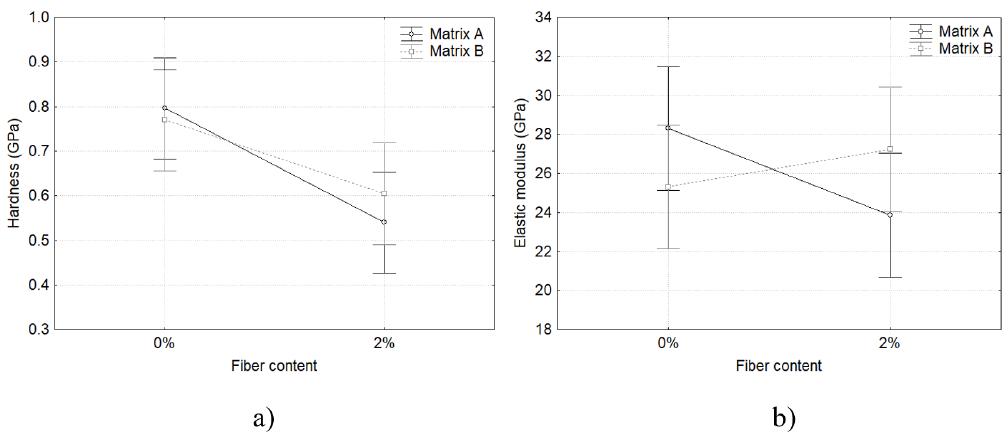
Figure 2. Results of hardness (a) and elastic modulus (b) obtained by the nanoindentation technique applied to cement pastes with w/c ratio of 0.3 with and without steel microfibers, varying the load from 100 mN (matrix A) to 50 mN (matrix B).